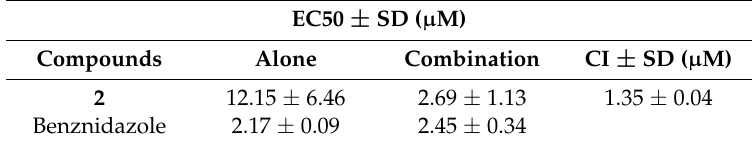
Table 2. Combined treatment of infected hFIB with compound 2 and